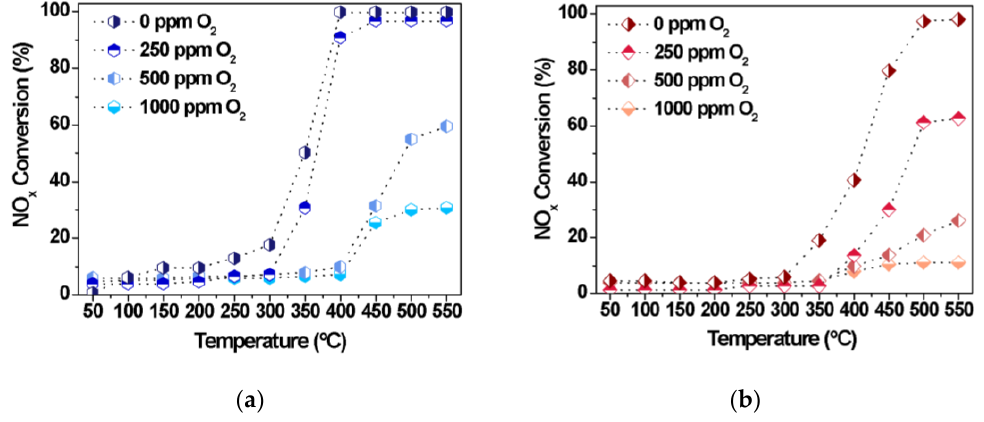
Figure 8. NO x conversions as a function of the temperature in the presence of distinct amounts of oxygen over ( a ) Cu 8 /SBA-15 and ( b ) Fe 10 /SBA-15 samples.